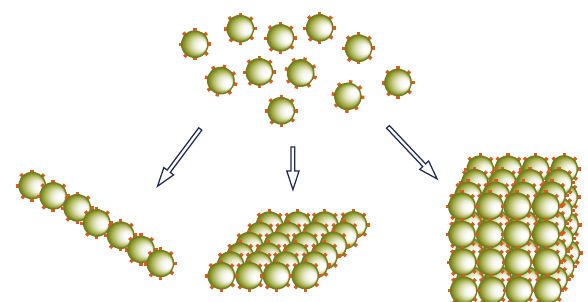
Figure 1: Schematic illustration of the organization of nanocrystals into chains, 2D sheets and 3D